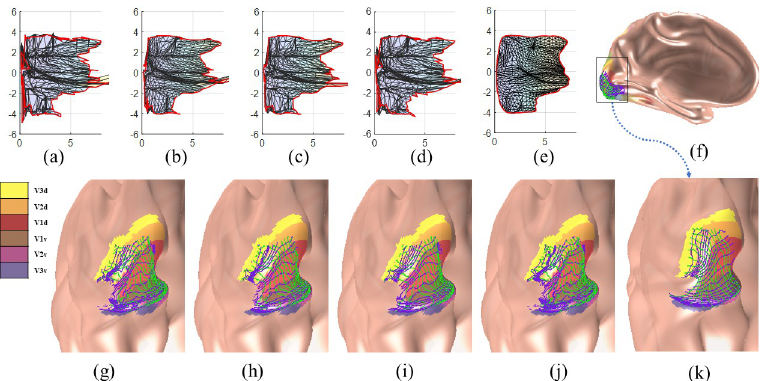
Fig 10. The retinotopic mapping of the V1/V2/V3 complex of the left hemisphere of the first observer: (A) the raw retinotopic map in the eccentricity-extended-polar coordinate space (with 232 flipped triangles), (B)-(E) the smoothing results of the Average (with 55 flipped triangles), Median (with 85 flipped triangles), Laplacian (with 151 flipped triangles), and the proposed smooth (no flipped triangles), respectively, (F) the entire left inflated mesh in medial view, (G) an enlarged graph of the raw retinotopic map on the inflated mesh, (H)-(K) smoothing results on the inflated surface of the four smoothing methods, in the same order of (B)-(E). In (A)-(E) the x axis is the eccentricity v (1) , and the y axis is the extended polar angle v (2) , in (H)-(K), the green and blue curves are levels sets, i.e., the contours of eccentricity v (1) and extended polar angle v (2) , respectively. the purple curves represent boundaries of visual areas (V3d/V2d/V1d/V1v/V2v/V3v, from up to down). As in the retinotopic maps, topological violations occurred in boundary delineation